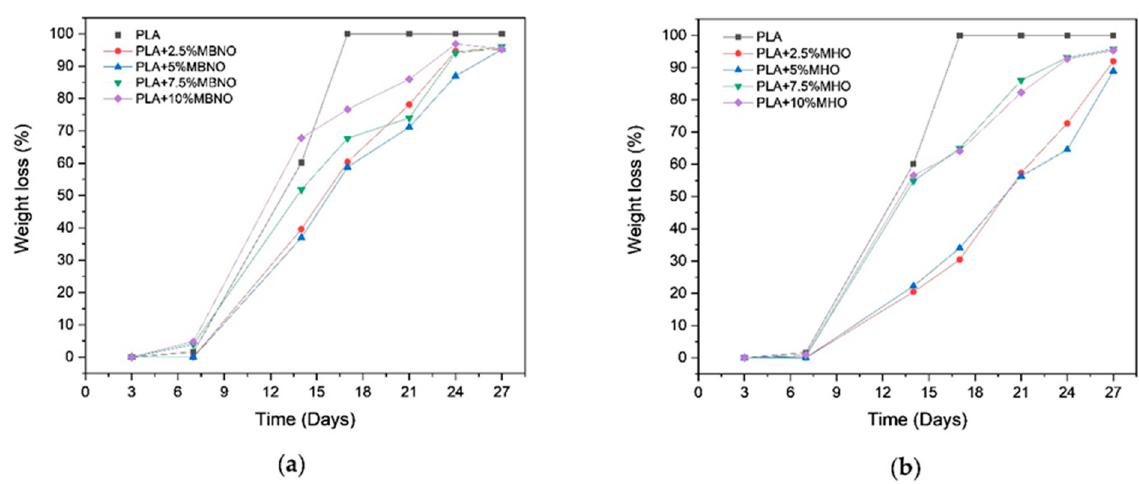
Figure 13. Weight loss recorded during disintegration test of PLA formulations with MBNO ( a ) and MHO ( b ).